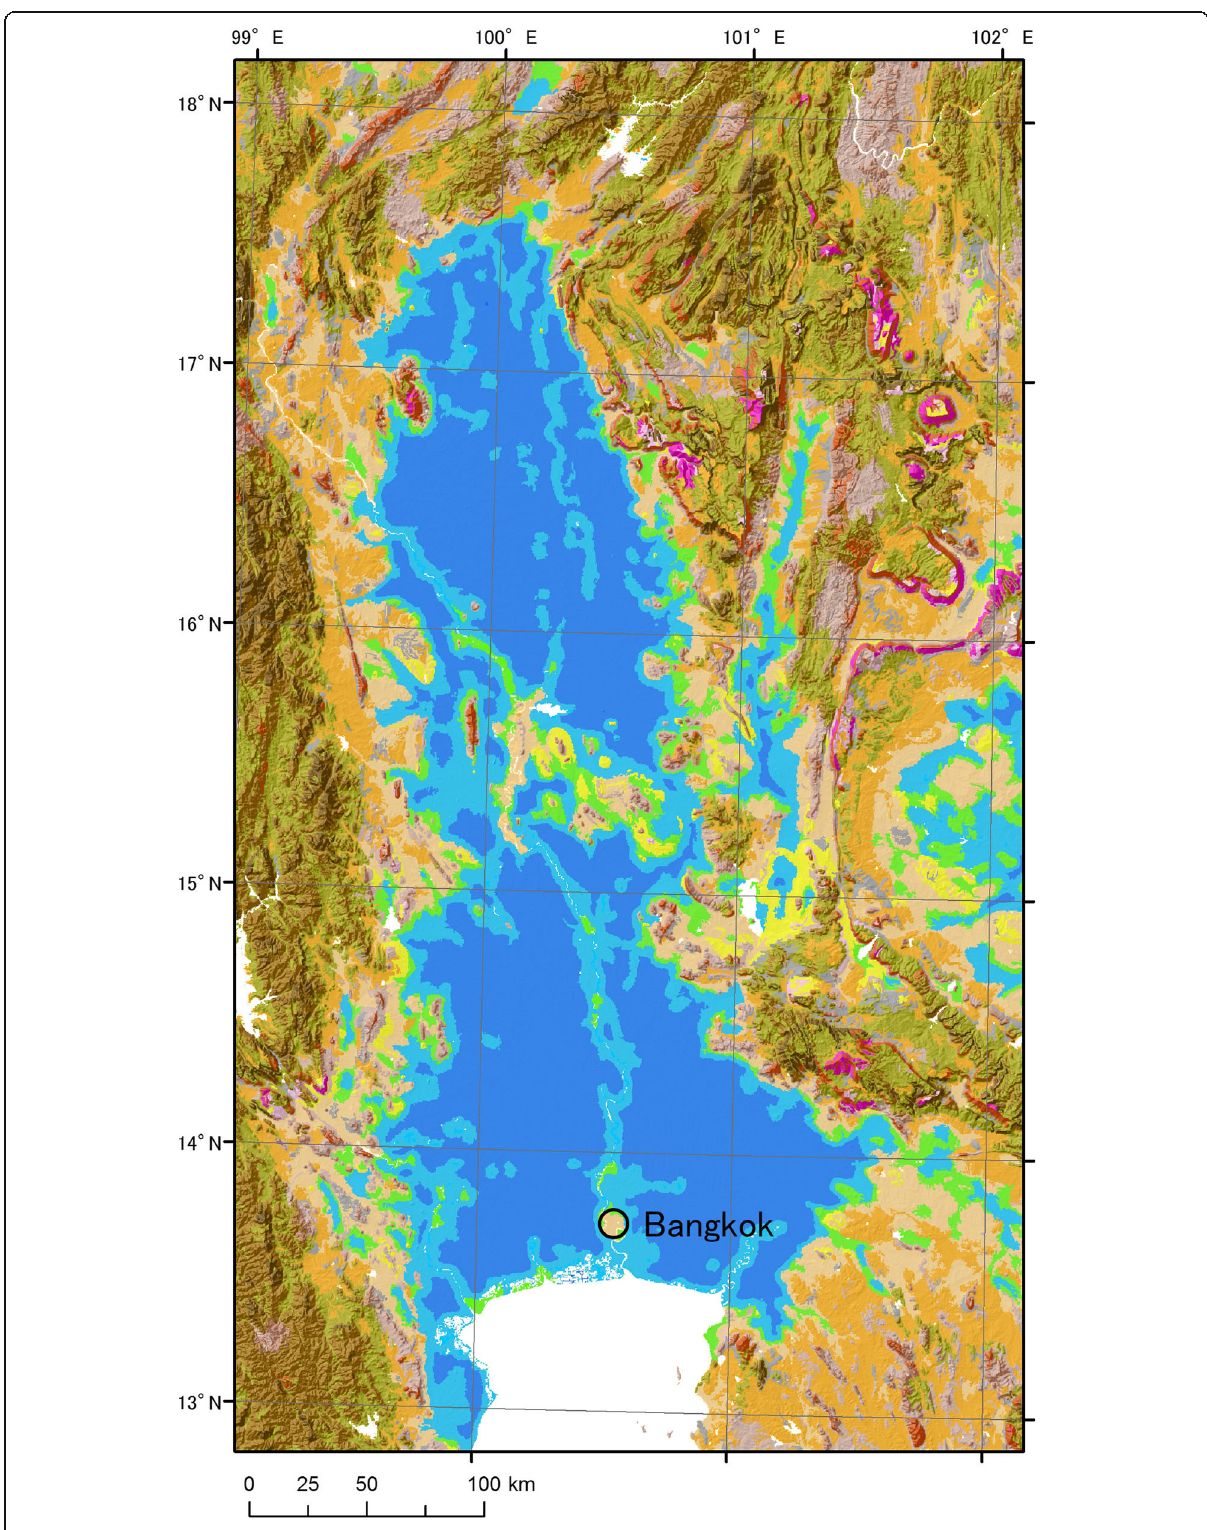
Fig. 19 Shaded terrain classification image of the Central Plain of Thailand and its